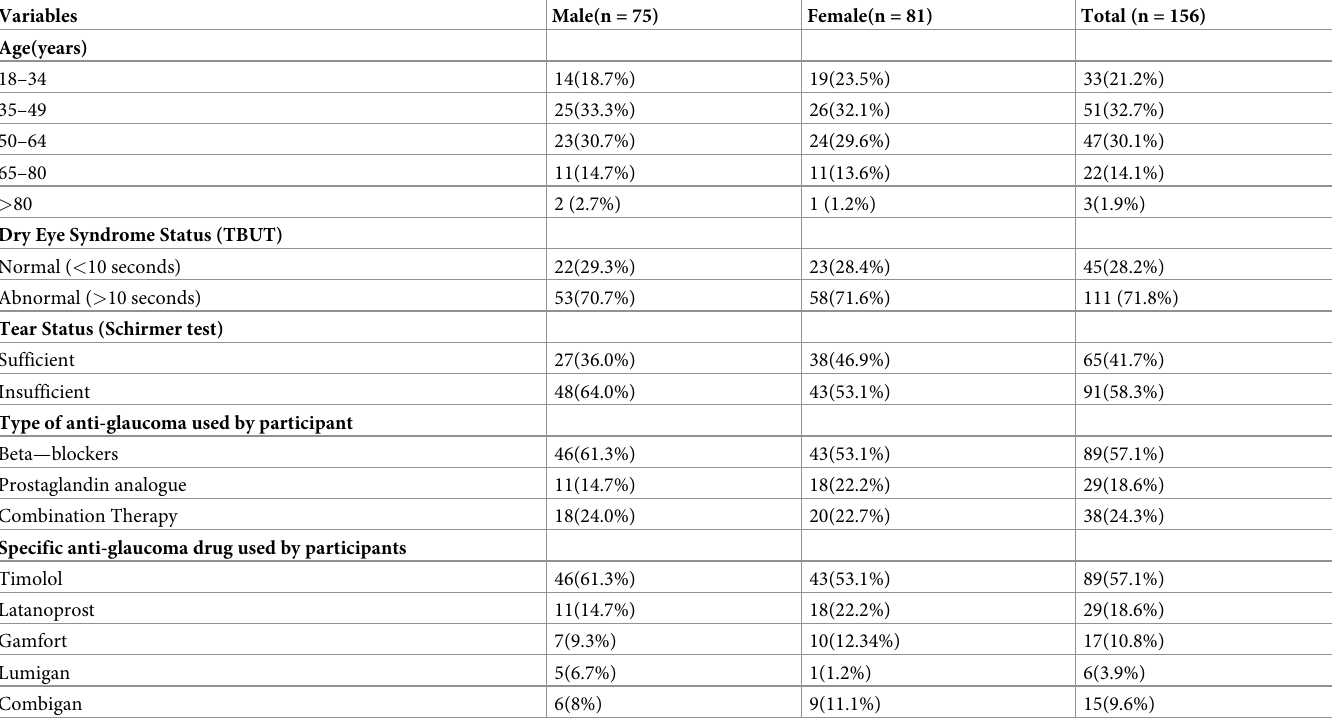
Table 1. General characteristics of study